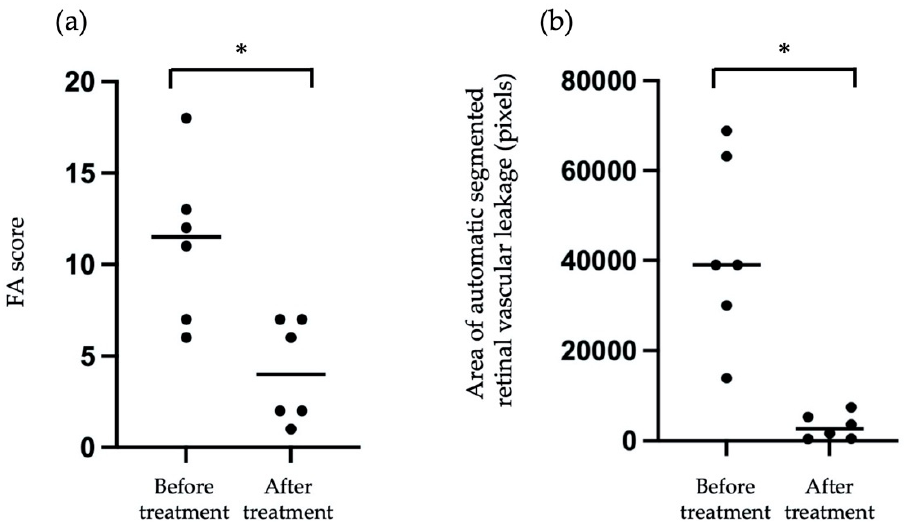
Figure 6. Comparison FA score ( a ) and mean pixels of automatic segmented vascular leakage in FA images ( b ) before and after treatment from six patients. Asterisk indicates p < 0.05 versus FA score or the pixels of automatic segmented vascular leakage in FA images before and after treatment. Statistical analysis was performed with the paired- t test.